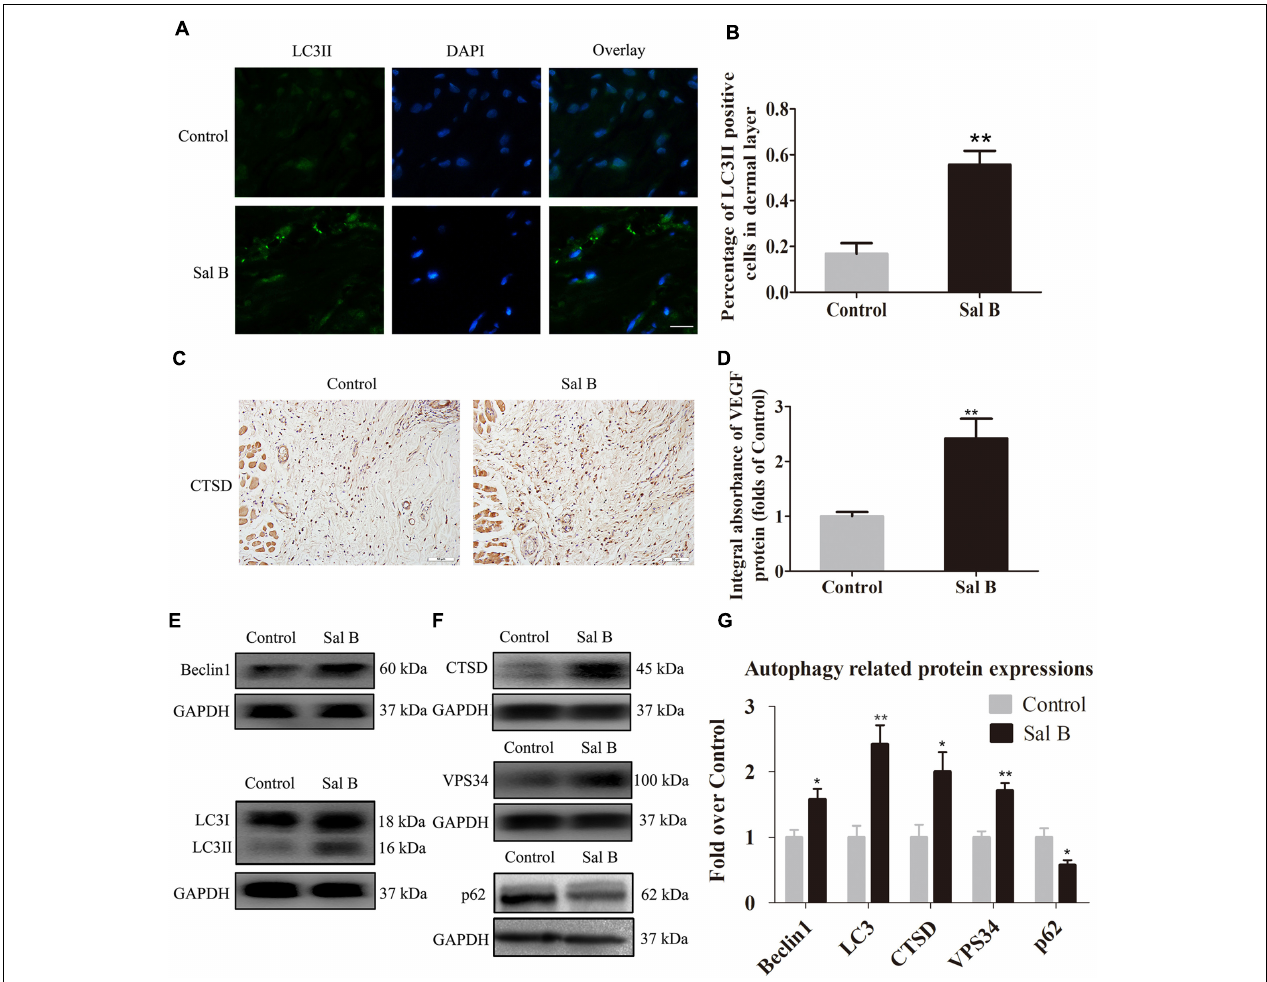
FIGURE 5 | Sal B activates autophagy in random skin flaps. Rats were killed and the samples in middle part of flap area II were harvested for analysis on post-operative day 7. (A) Autophagy level in skin flaps were estimated by immunofluorescence staining of LC3II: autophagosomes (green) in the dermis in area II in each group; nuclei counterstained with DAPI (blue) (scale bar: 15 µ m). (B) Histogram of frequency of LC3II-positive cells. (C) CTSD expression by IHC (original magnification: 200 × ; scale bar: 50 µ m). (D) CTSD levels in random skin flaps as estimated by Western blotting. (E,F) Beclin1, LC3II, CTSD, VPS34, and p62 levels by Western blotting, respectively, corrected by GAPDH as internal control. The gels have been run under the same experimental conditions. The original images are available in Supplementary Figure S1D . (G) Histograms of optical density values of Beclin1, LC3II, CTSD, VPS34, and p62 expressions as determined by Western blotting. ∗ p < 0.05 and ∗∗ p < 0.01 vs. the control group. Data are means ± SEM ( n = 6 per